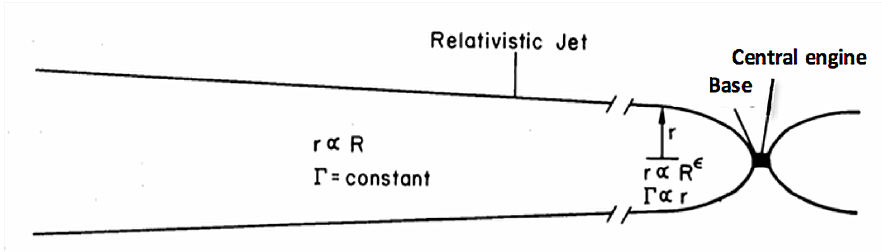
Figure 1. Sketch of the relativistic jet model proposed by the author in 1980 [15]. Here, Γ is the bulk Lorentz factor of the flow, r is the cross-sectional radius, and R is the distance from the base of the jet.